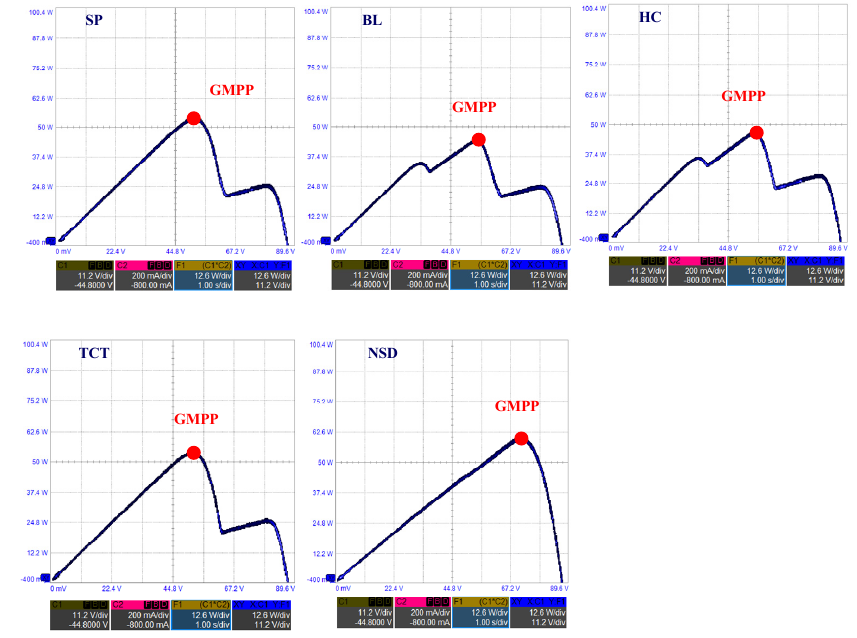
Figure 12. PV curves under PSC case I.